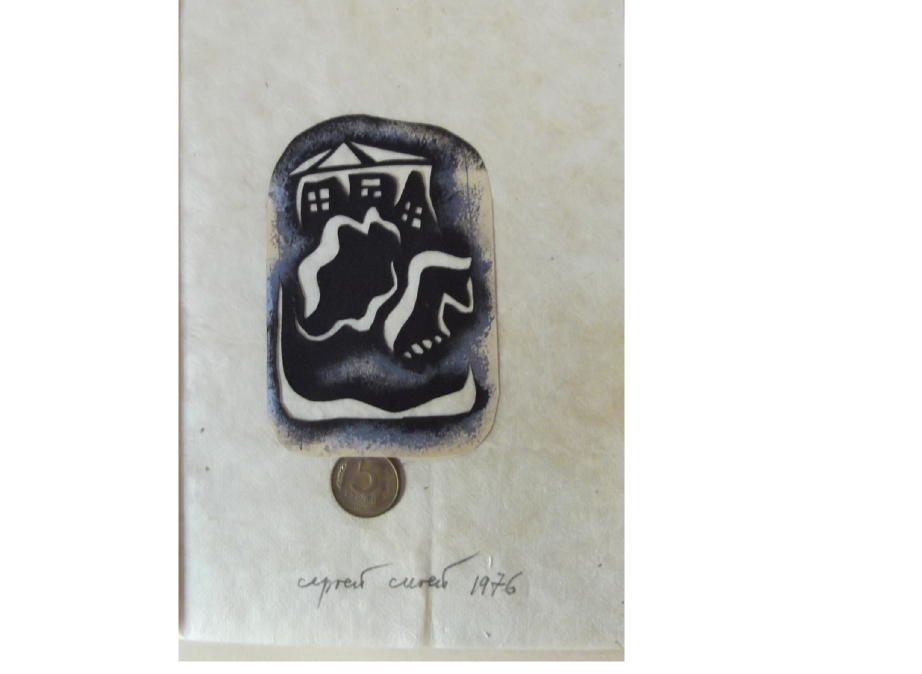
Figure 14. Page from the first booklet.